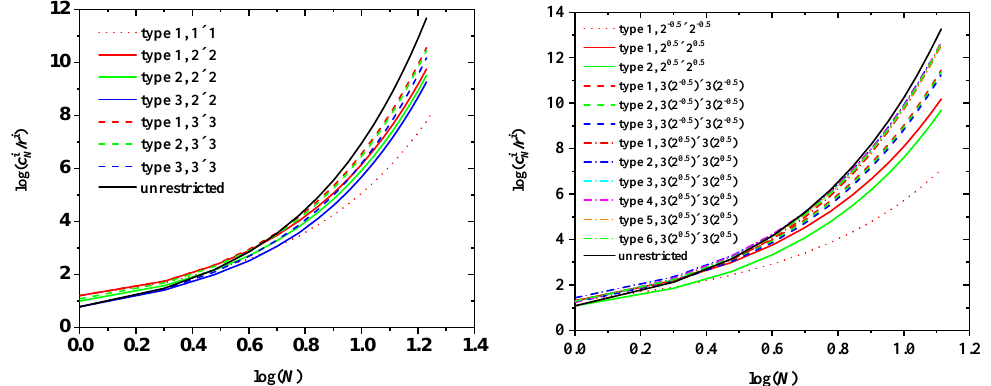
Figure 16. Log-log plot of the number of distinct SAW configurations scaled by the inverse overlap, c i / r i , as a function of SAW steps, N , on confined SC (left panel) and FCC lattices (right panel) for N various origin types and tube cross-sections. Also shown for comparison are the corresponding results for the unrestricted SAW (solid black